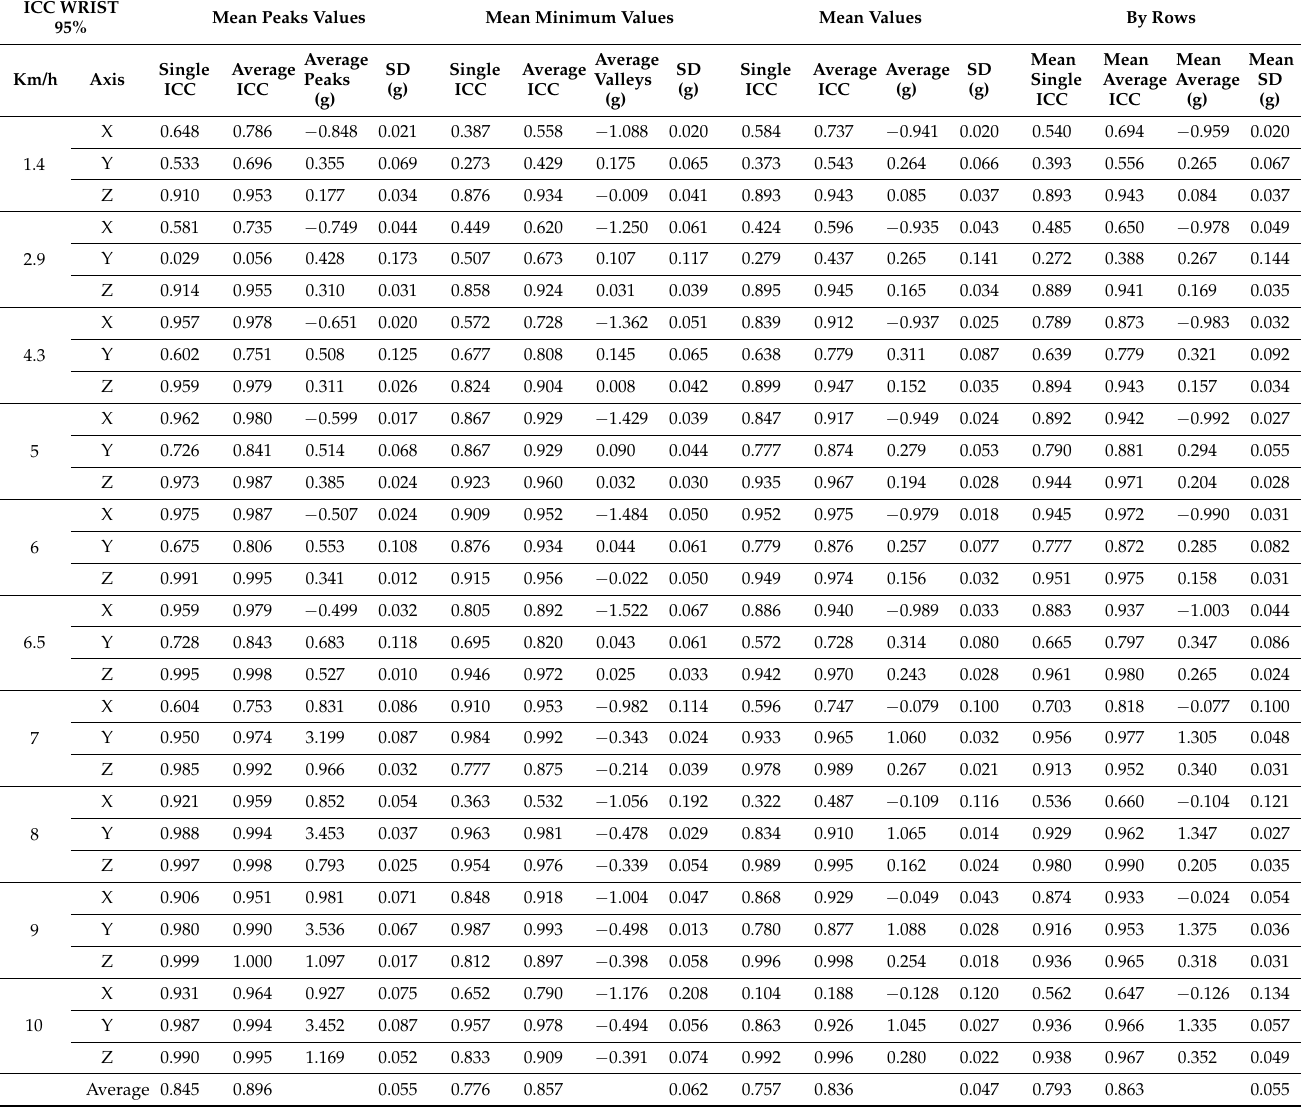
Table 1. ICC values and standard deviation grouped by speed (km/h) and axis, in wrist